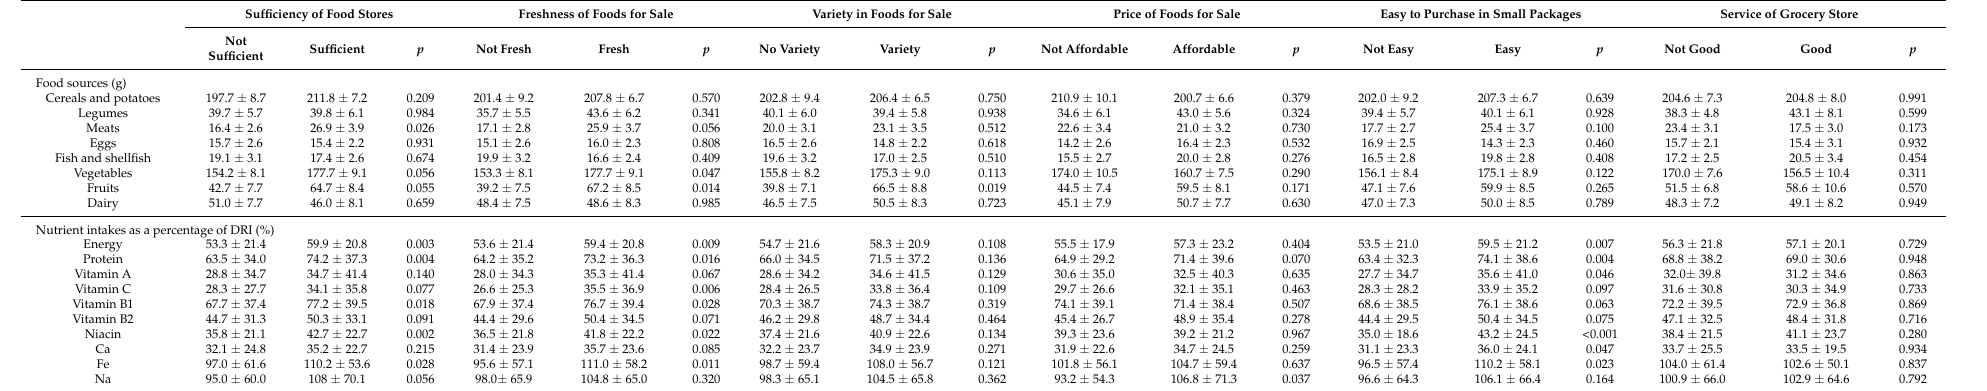
Table 4. Food and nutrient intake, according to food store accessibility